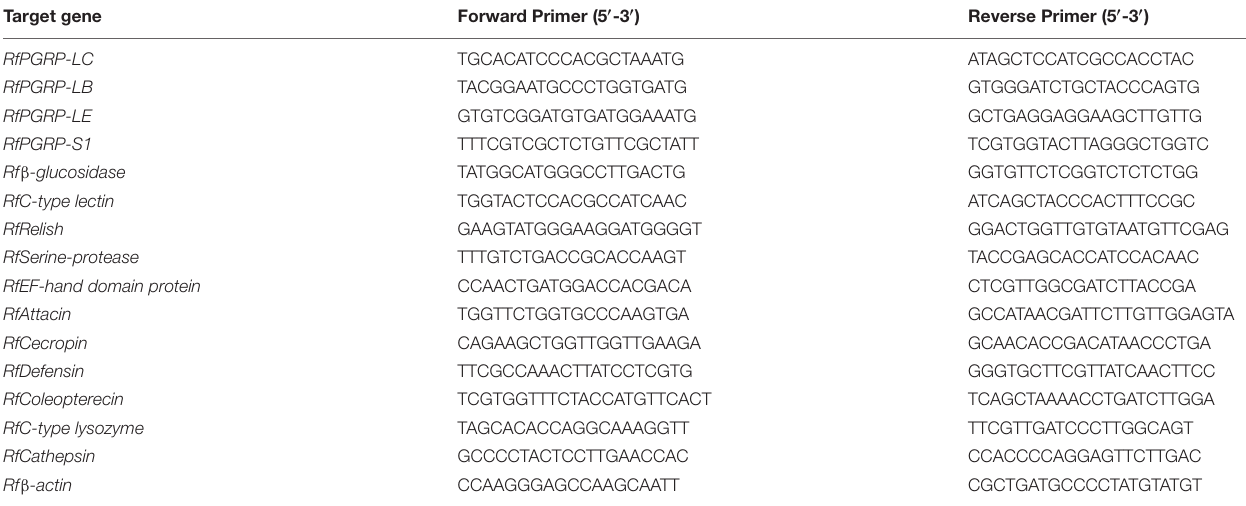
TABLE 1 | The specific primers used for RT-qPCR analysis. Target gene Forward Primer (5 (cid:48) -3 (cid:48) ) Reverse Primer (5 (cid:48) -3 (cid:48)